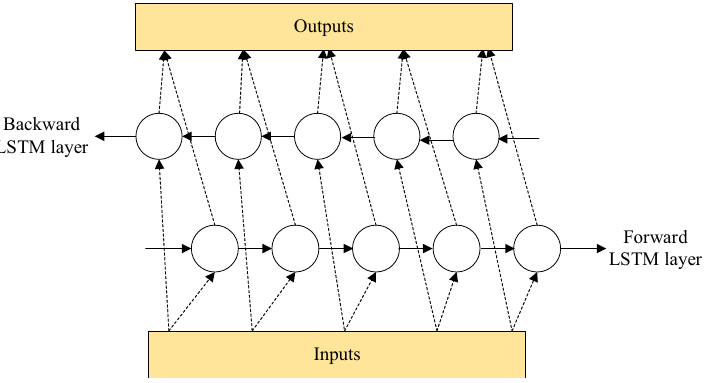
Figure 3. The diagram of the BiLSTM